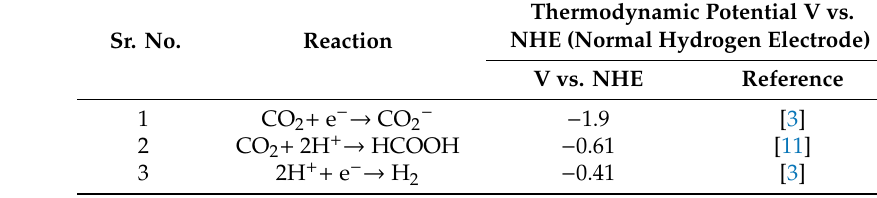
Table 2. Thermodynamic potential of CO 2 into di ff erent products.